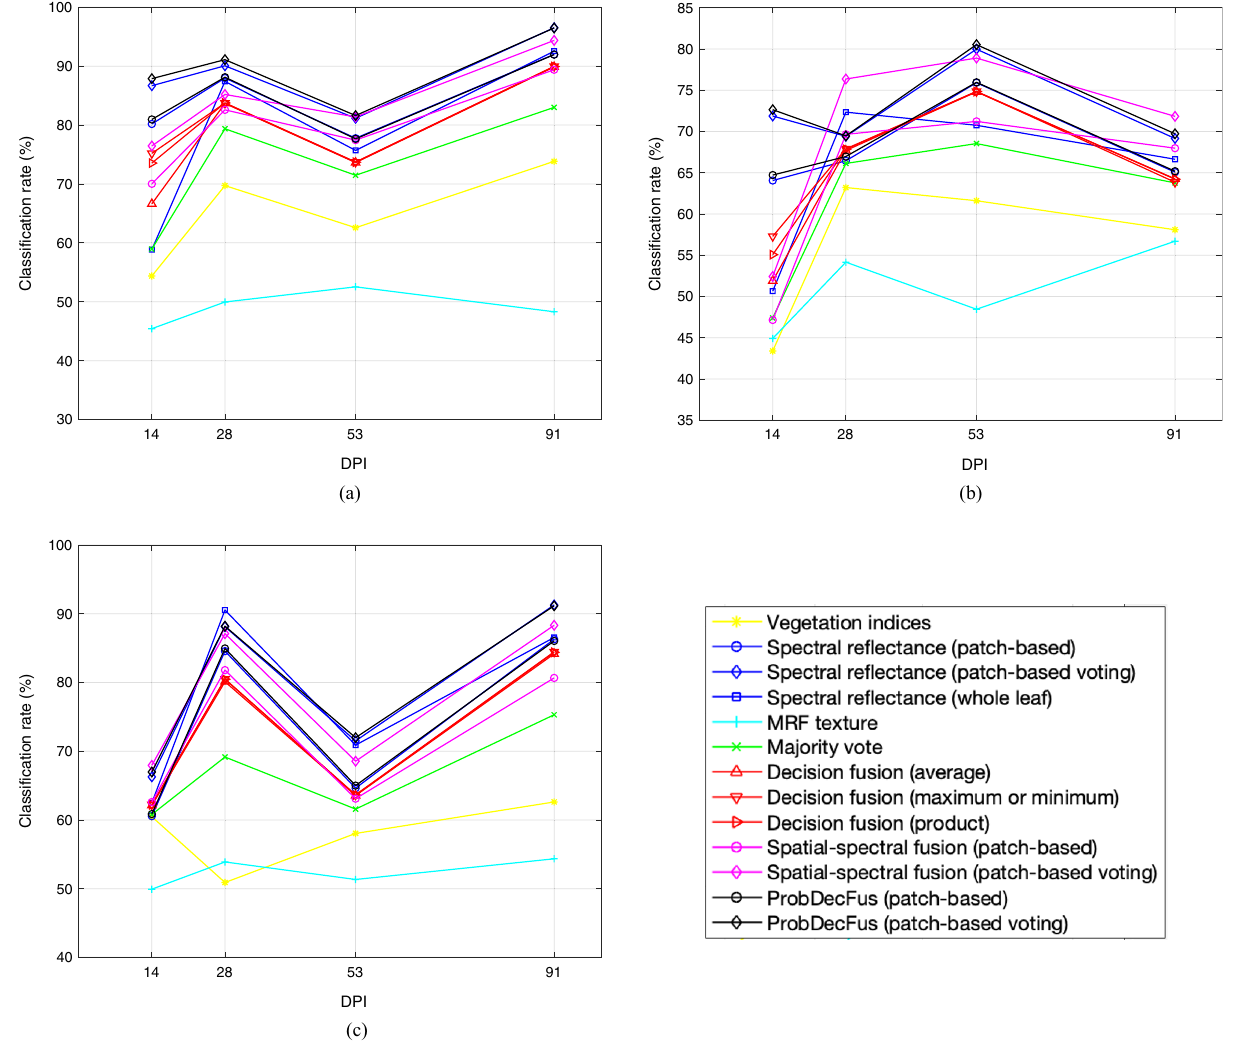
Figure 4. Classification accuracy (%) from leaf scans on Cassava-Kiroba-UCBSV dataset, at 14, 28, 53 and 91 dpi, respectively, ( a ) control versus infected, ( b ) mock versus infected, and (c) control versus